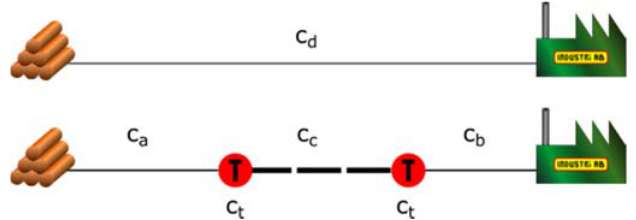
Figure 5. Cost items in a conventional (top) and HCT system (bottom).